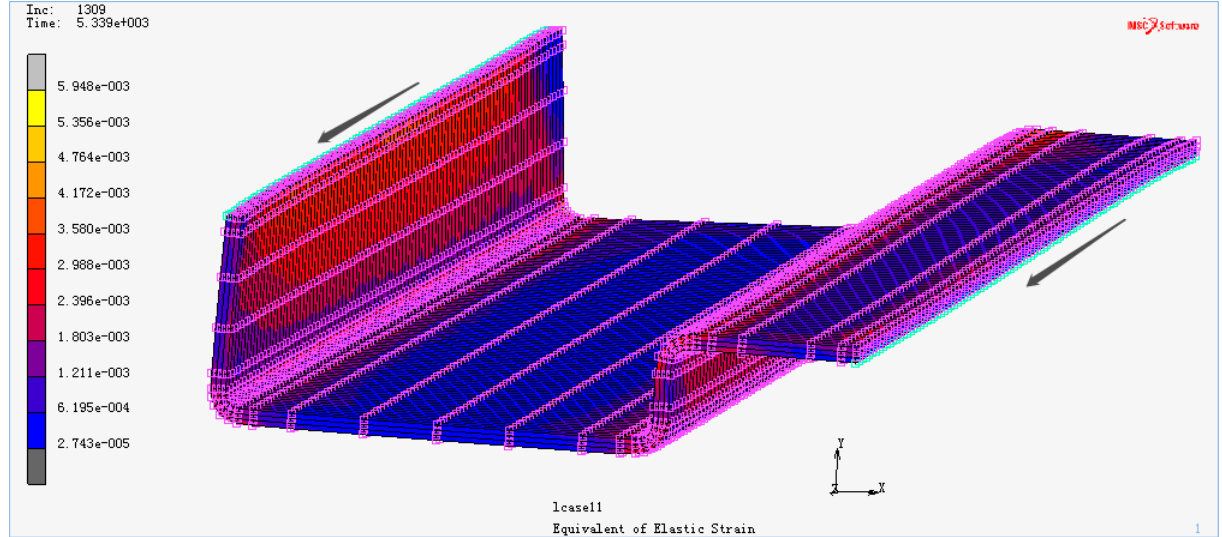
Figure 7. The node was used to extract the path and direction.